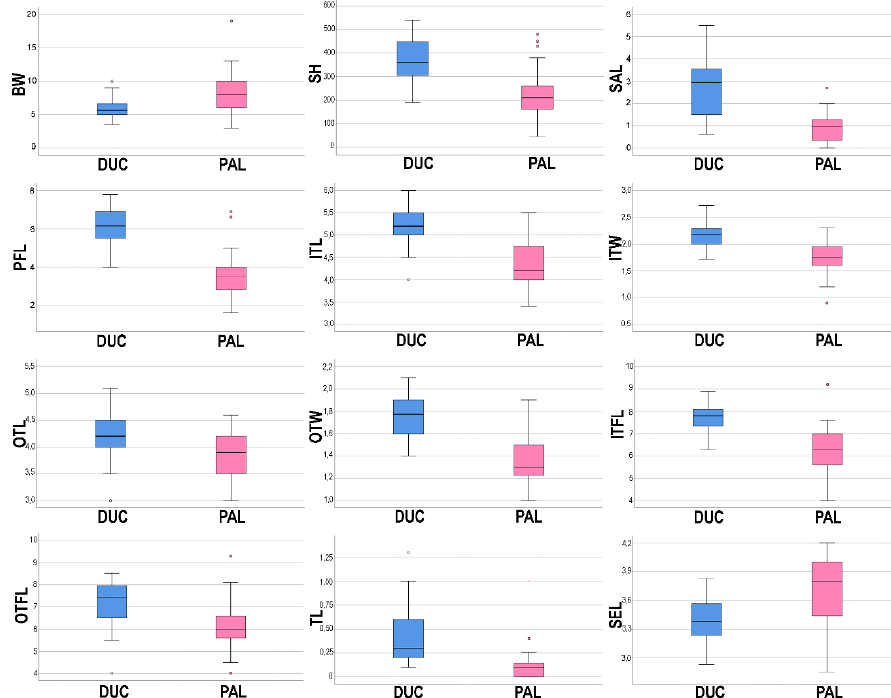
Figure 7. Principal coordinates analysis (PCoA) based on the distance matrix of Bray–Curtis dissimilarity. Scatter plot of first two principal coordinate axes based on 21 morphological characters and 80 specimens.